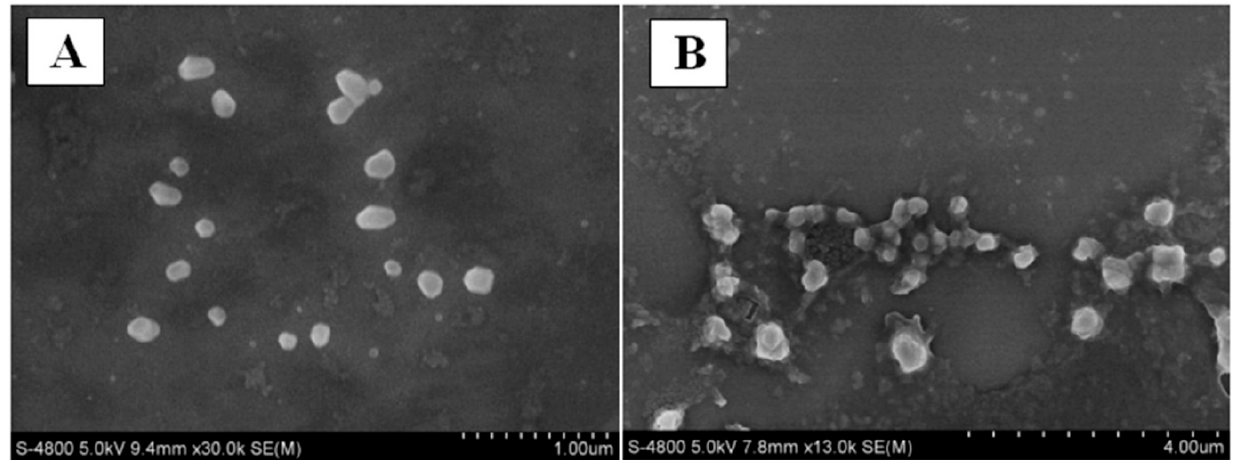
Figure 9. Scanning electron microscopy images of CSNPs ( A ) without loading of BEO, and ( B ) with a loaded ratio of 1:0.5 with BEO. Reproduced with permission from Cai et al. [93]. Copyright 2022 Elsevier.